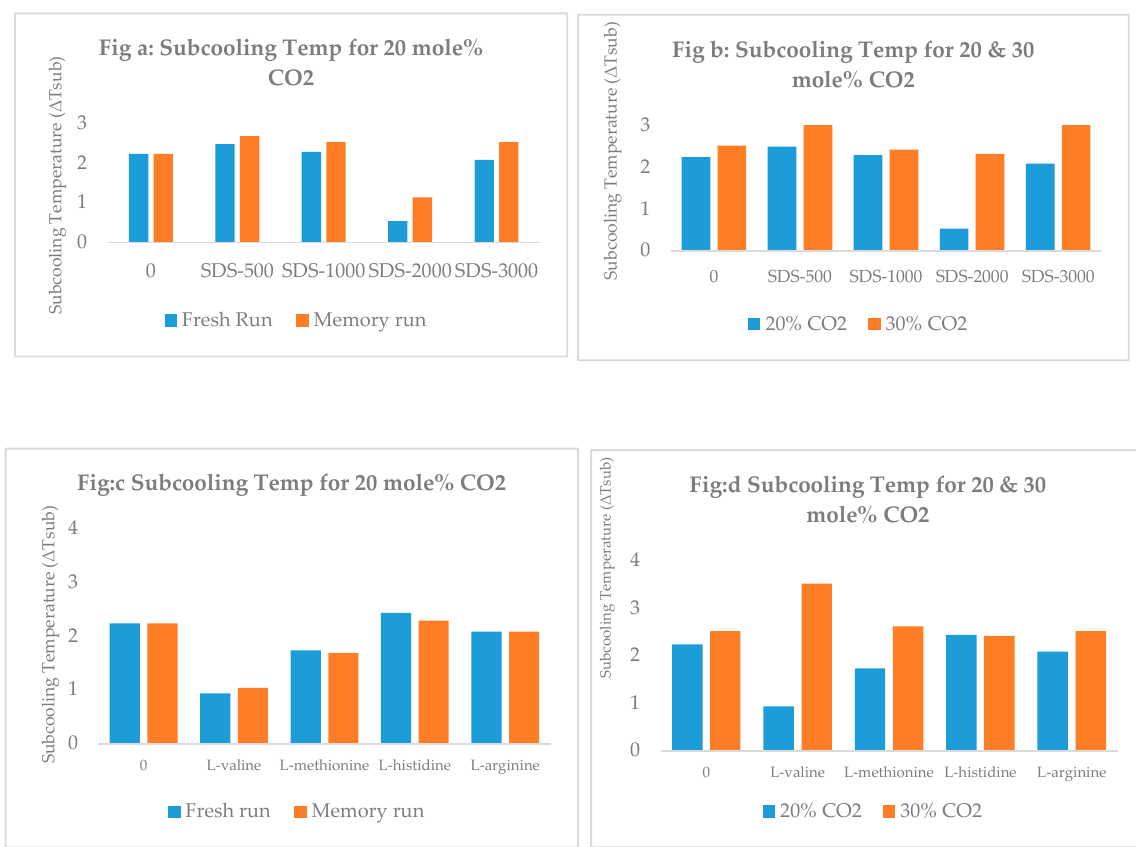
Fig b: Subcooling Temp for 20 & 30 Fig a: Subcooling Temp for 20 mole%